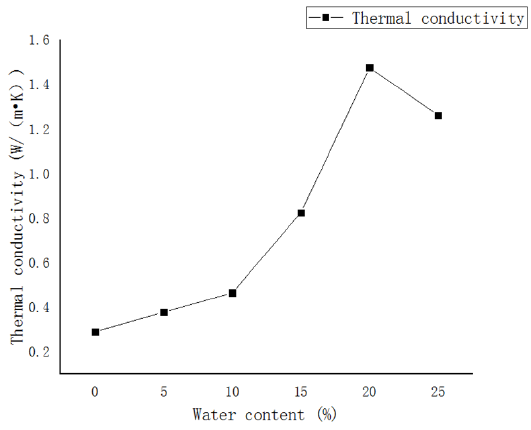
Figure 4. The curve between soil moisture content and thermal conductivity.